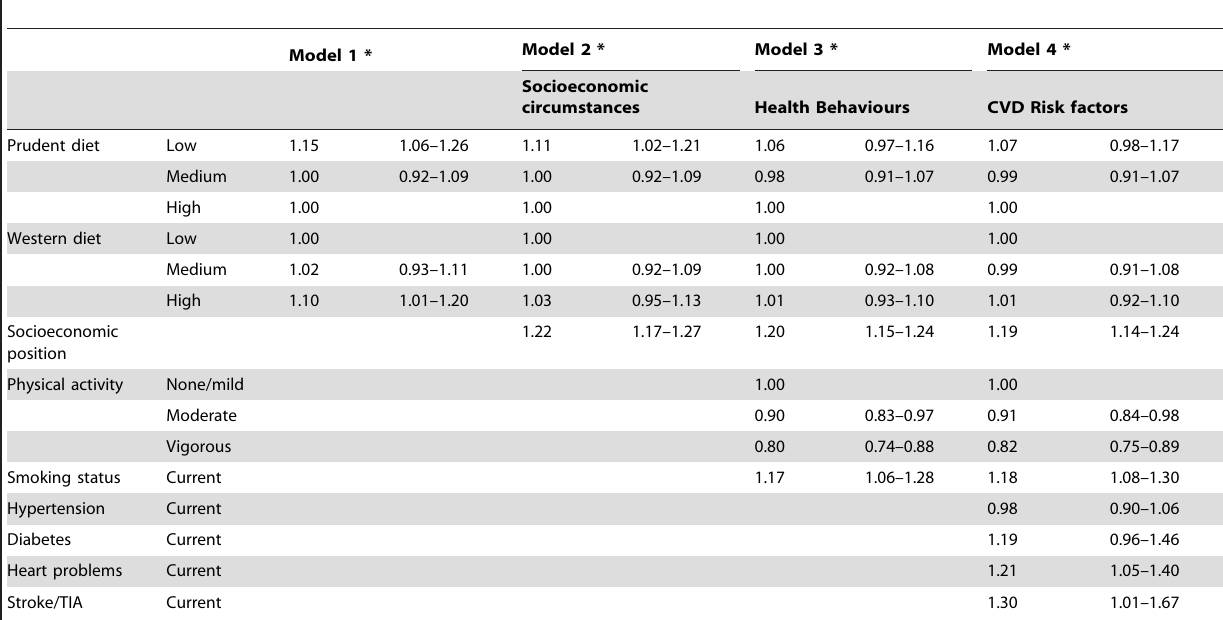
Table 2. Results from series of cross-sectional negative binomial regression models investigating the association between tertiles of prudent and western diet intake and number of depressive symptoms reported at